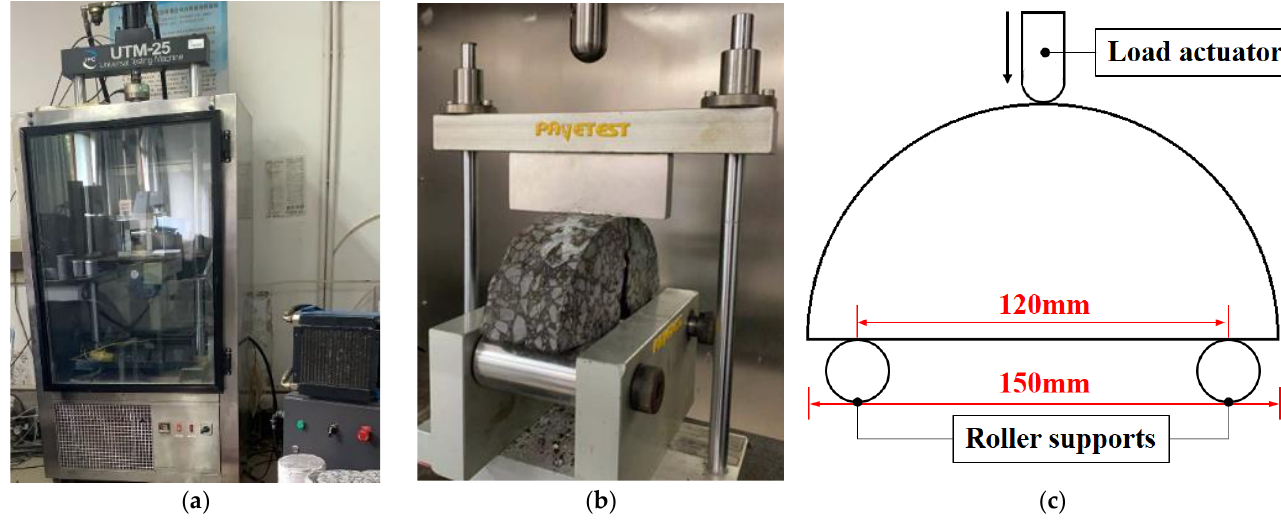
Figure 4. ( a ) UTM-25 universal testing system; ( b ) Bend test fixture; ( c ) Specimen under SCB test. The FI is defined by Equation (1) using the parameters obtained from the load–displacement curve of the SCB test, as shown in Figure 5. A simple correction factor was established to eliminate the effect of thickness variations on the FI, as expressed in Equation (1) [41]. Considered as the evaluation index, the tensile strength ( σ t ) of the un-notched SCB specimen geometry was determined using Equation (4) as follows [14]: